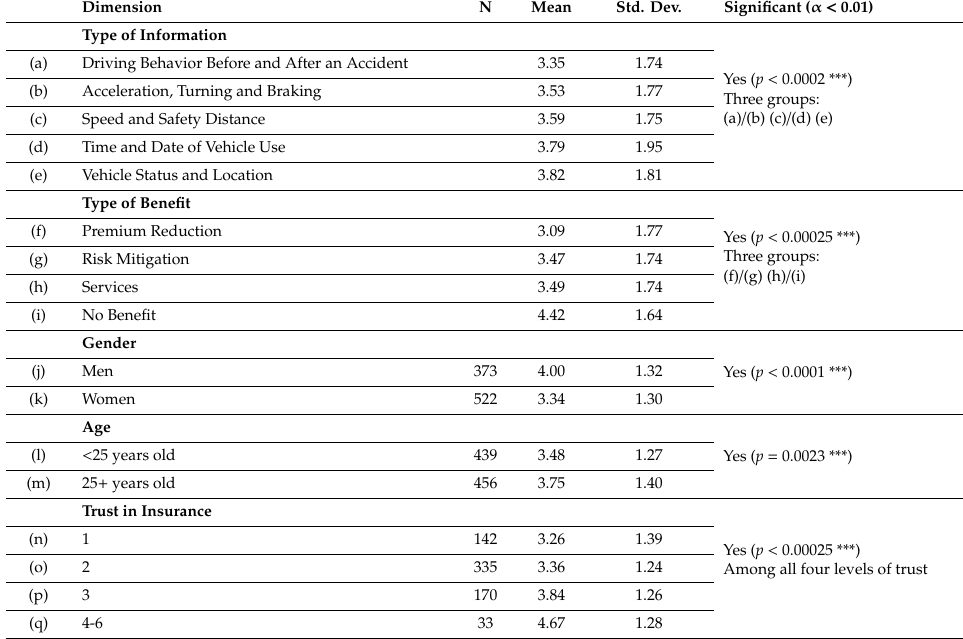
Table 4. Willingness to share information by dimension (*** denotes α < 0.001).